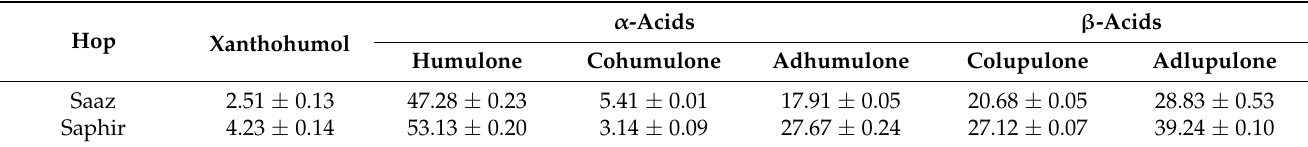
Table 1. Xanthohumol, isoxanthohumol, α -acid, and β -acid contents (mg/g of dry extract) of the Saaz and Saphir ethanol